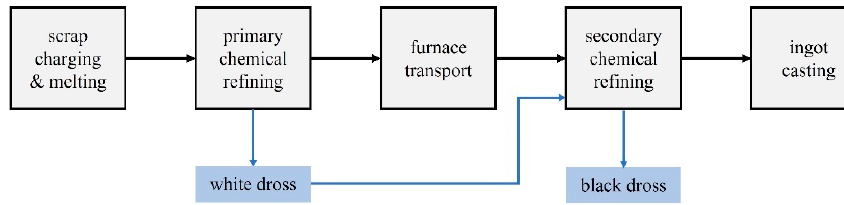
Figure 3. Magnesium recycling process.